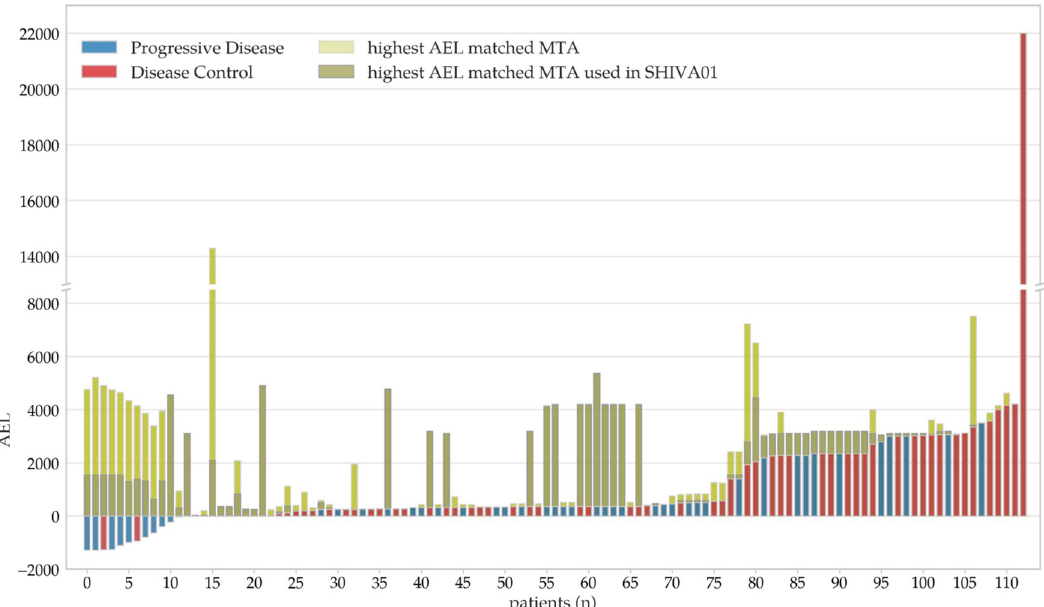
Fig. 6 Distribution of MTAs with the highest AEL values assigned by the digital drug-assignment (DDA) for patients in the SHIVA01 trial. In addition to DDA AEL scores of MTAs used in SHIVA01 patients with progressive disease (PD) (blue bars) and patients achieving DCR (red bars). The DDA AEL levels of MTAs with the highest AEL values assigned by the DDA out of the 11 MTAs used in the SHIVA01 trial (dark green bars) and out of all 631 MTAs in the current database of the DDA system (light green